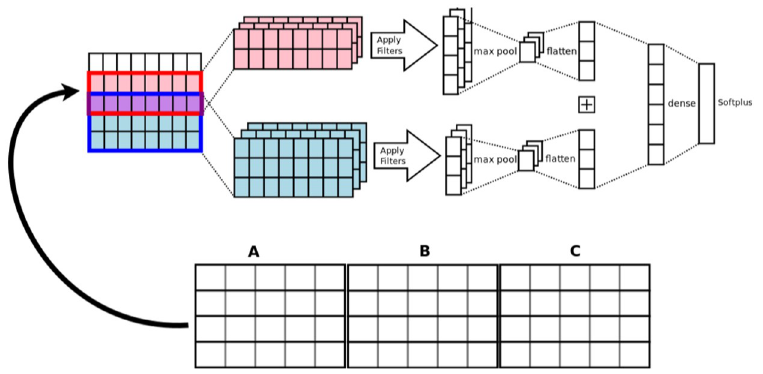
Fig 1. The open discovery 2 model.